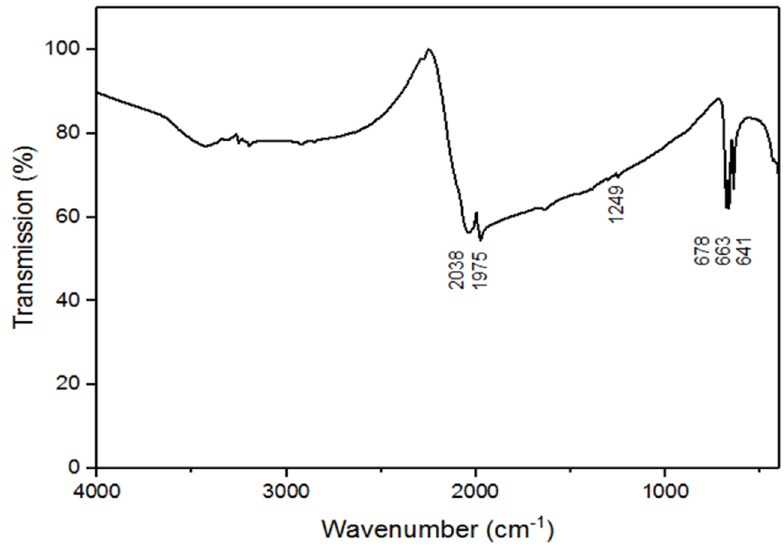
Figure 3. Infrared spectrum of BaZn(NCN) 2 . Table 1. Comparison of bond lengths d and angles θ in BaZn(NCN) 2 from both unrestrained ( obs (unres)) and restrained ( obs (res)) Rietveld refinements as well as DFT calculations ( calc ). d obs (unres)